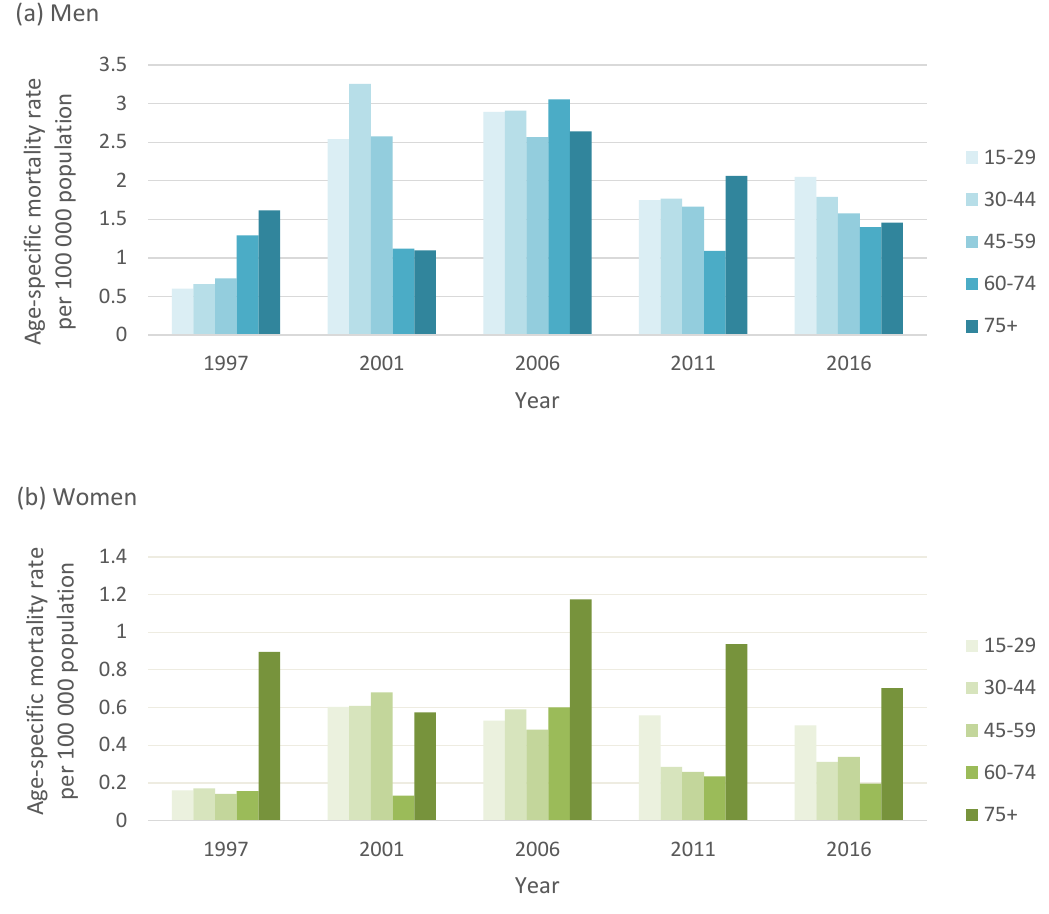
Figure 3. Age-specific suicide rates in men and women by broad age groups in South Africa across 5-year intervals. ( a ) Men; ( b ) Women.